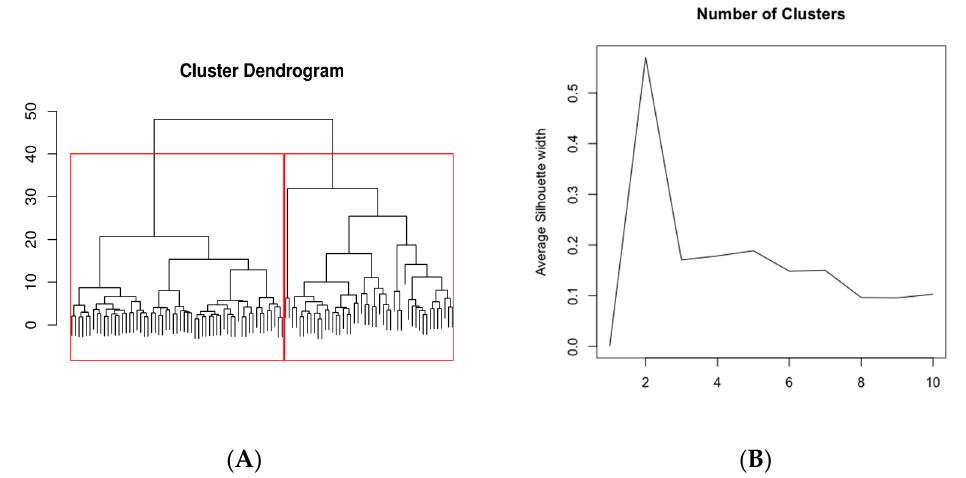
Figure 1. Cluster dendogram and number of clusters. The dendrogram resulting from the application of the hierarchical clustering is reported in the left panel ( A ). Right panel ( B ) shows the number ( n = 2) of clusters identified according to the silhouette index.